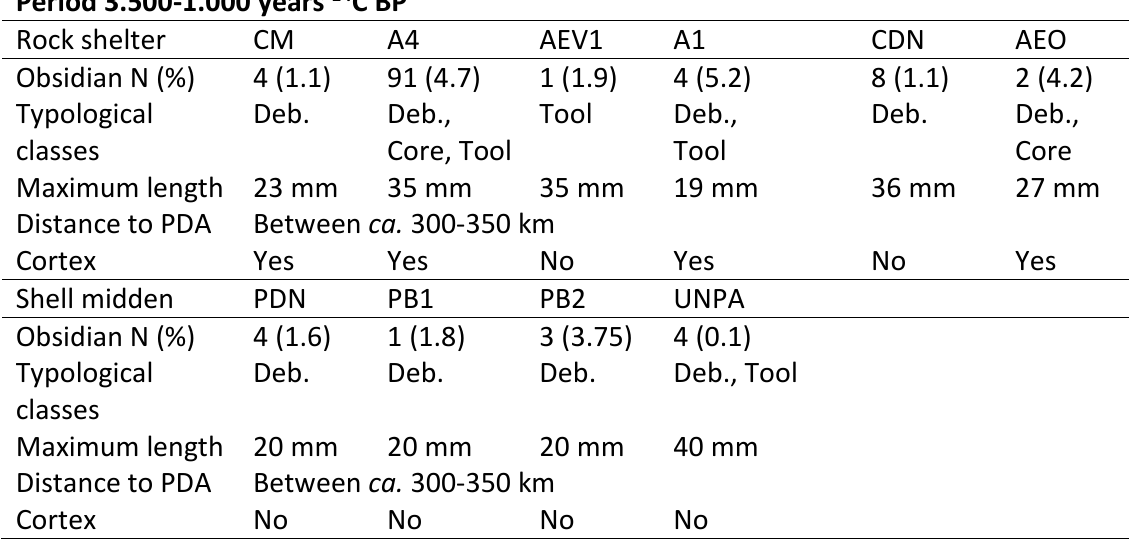
Table 3. Characteristics of obsidian assemblages of the period 3,500-1,000 years 14 C